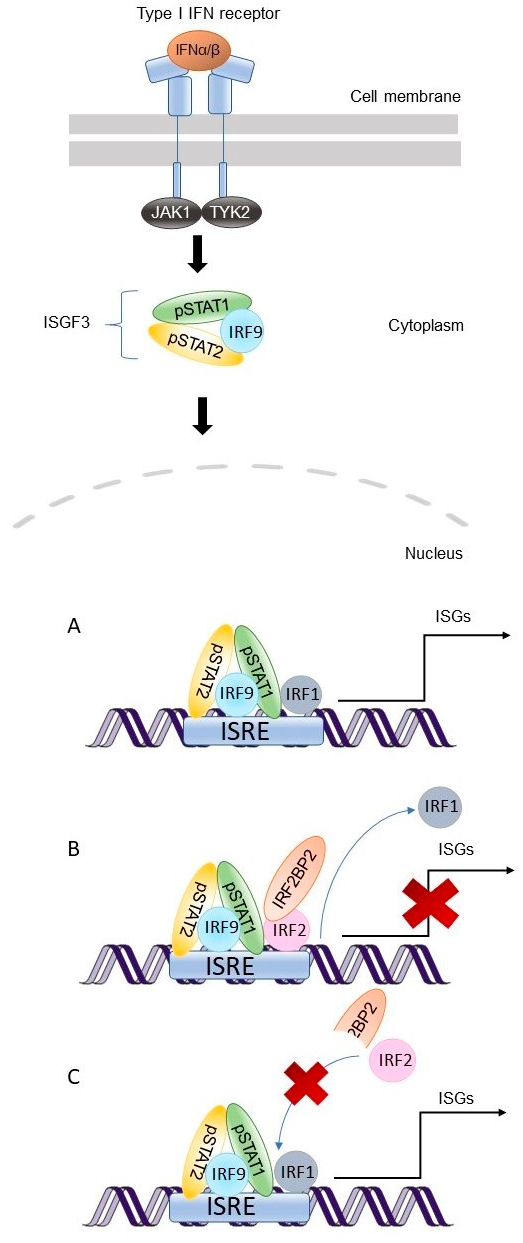
Figure 4. A schematic picture illustrating the suggested role of IRF2BP2 in type I interferon (IFN) signaling. IFN binding to their receptors activates JAKs, which phosphorylate STATs. Upon IFN α or IFN β stimulation, the transcription factor complexes called interferon-stimulated gene factor 3 (ISGF3) that consist of STAT1, STAT2, and interferon regulatory factor 9 (IRF9) are formed. These transcription factor complexes translocate to the nucleus and bind to interferon-stimulated response elements (ISRE). ( A ) IRF1 is a transcription factor that co-operates with ISGF3 to induce interferon-stimulated genes (ISGs). ( B ) IRF2 restricts the induction of ISGs by competing with IRF1 for the same binding site. IRF2BP2 acts as a co-repressor of IRF2 by binding to it through the C-terminal RING domain and is essential for IRF2 ability to limit the expression of ISGs. ( C ) Patient mutation IRF2BP2 c.625_665del generates a truncated IRF2BP2 protein (238 amino acids of 587) that entirely lacks the RING domain. Truncated IRF2BP2 cannot bind to IRF2, which in turn is unable to bind DNA and suppress IRF1 function. IFN; interferon, IRF; interferon regulatory factor, IRF2BP2; interferon regulatory factor 2 binding protein 2, ISGF3; interferon-stimulated gene factor 3, ISRE; interferon-stimulated response element, JAK; Janus kinase, STAT; signal transducer and activator of